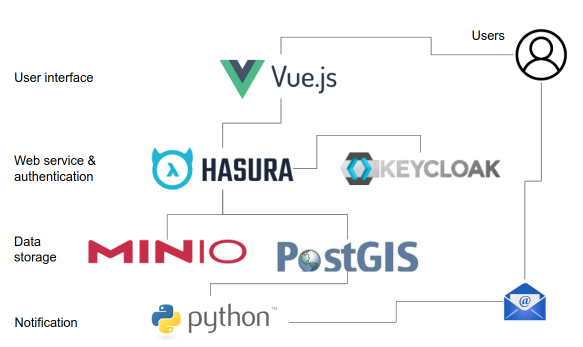
Figure 4. Architecture of digital management proposed solution.